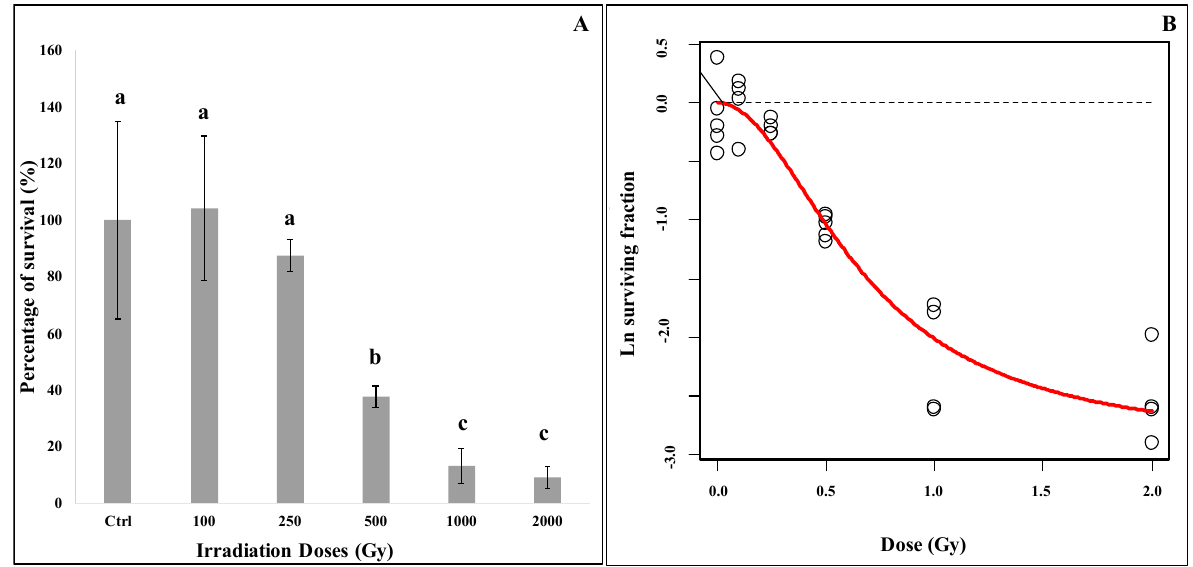
Figure 1. ( A ) Survival of fungal colonies in liquid media exposed to accelerated Fe ions. ( B ) Mathematical model of cell survival dose response. The same letters above bars indicate that the values are not statistically significant according to the t test ( p ≤ 0.05).